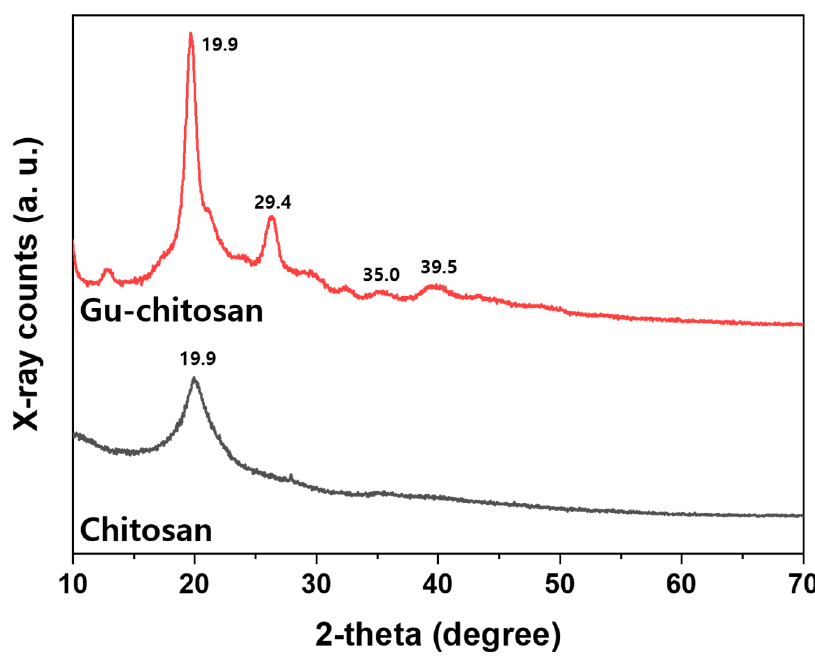
Figure 5. XRD spectra of chitosan and Gu-chitosan. Table 1. Elemental analysis and degree of substitution of chitosan and